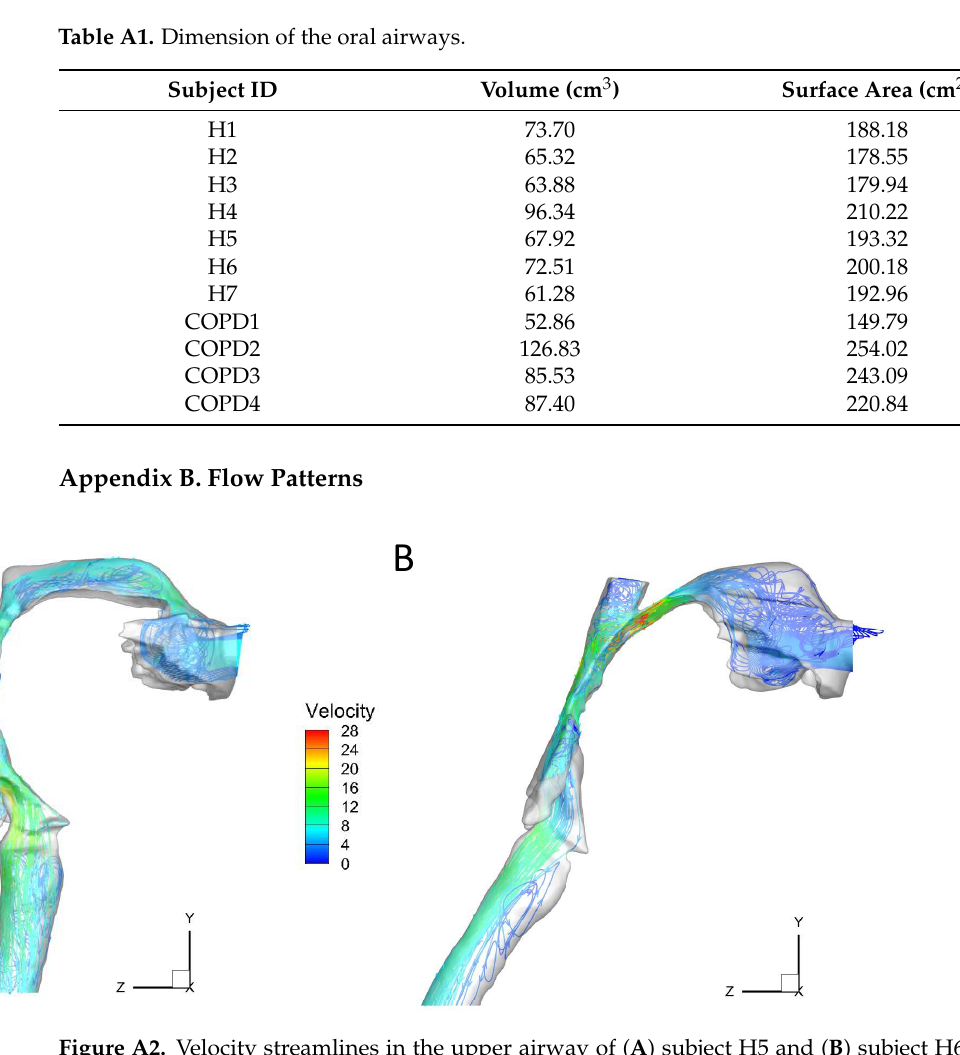
Figure A2. Velocity streamlines in the upper airway of ( A ) subject H5 and ( B ) subject H6 during inhalation at a flow rate of 45 L/min. Velocity scale is shown in m/s.